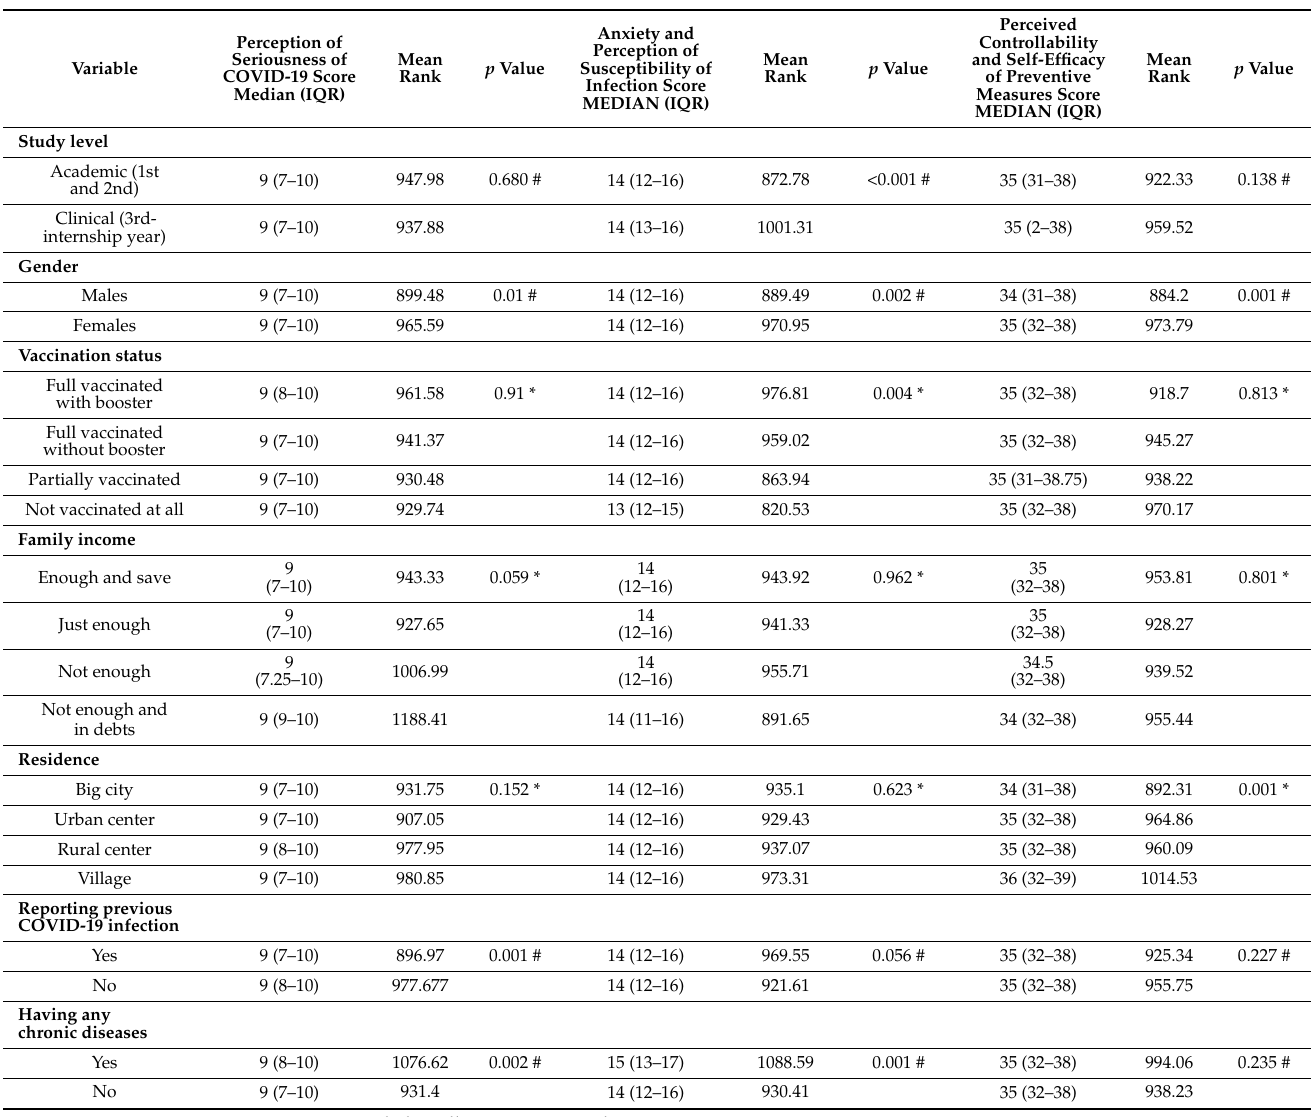
Table 2. Analysis for risk perception aspects following